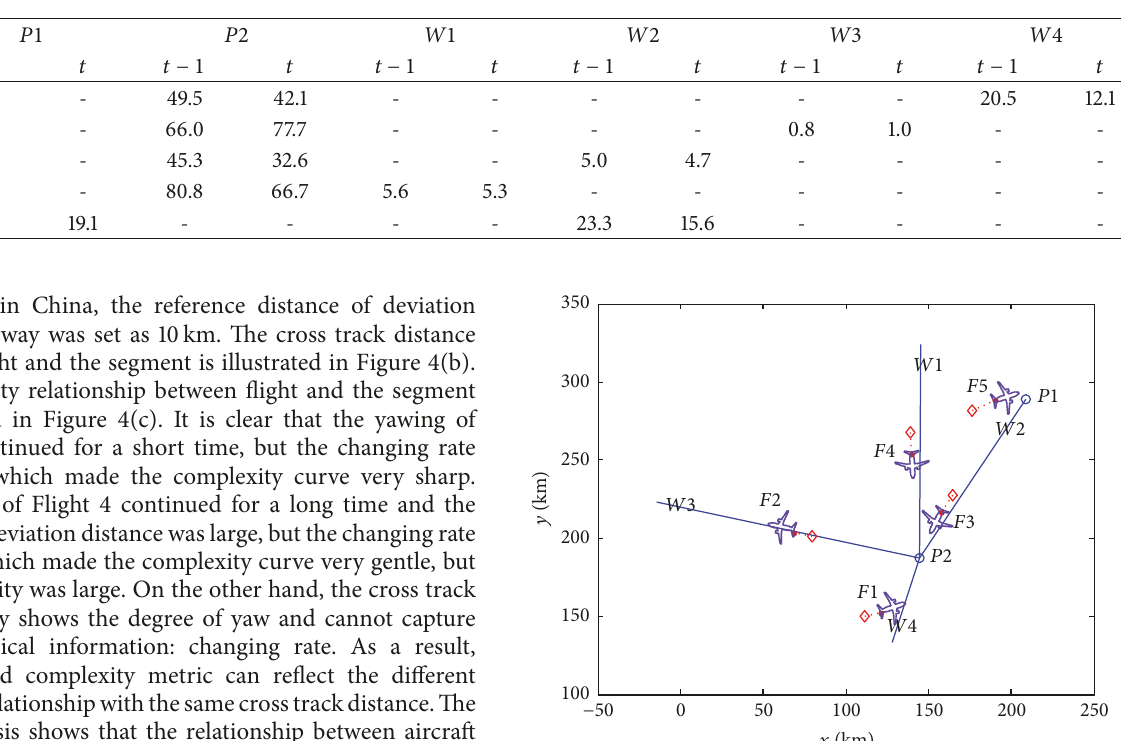
Table 2: Distances between aircraft and waypoints and between aircraft and segments at the current and previous time points.